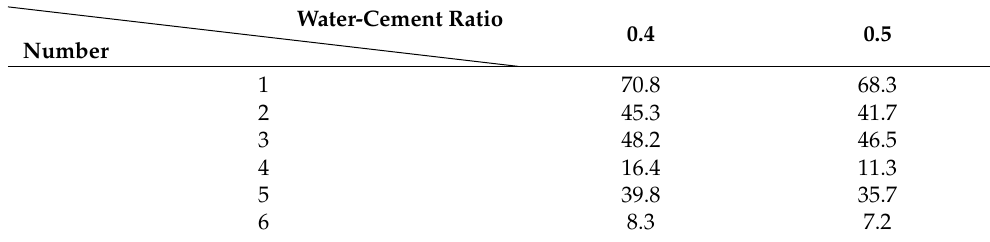
Table 9. Initial cracking time under different curing environments (unit in the table: h).